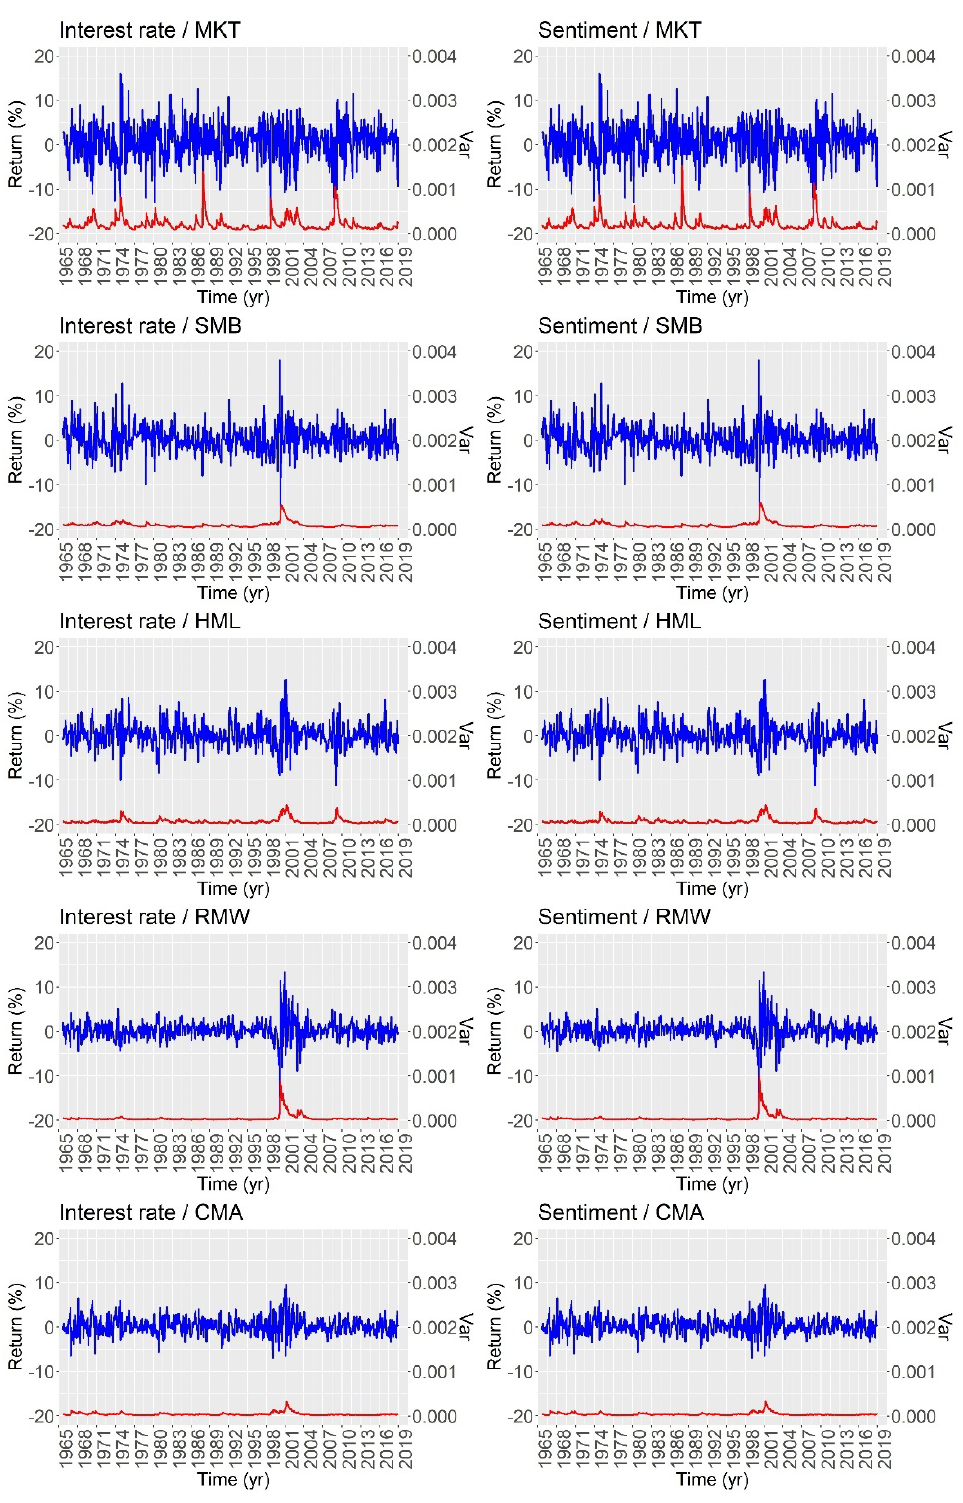
Figure 1. Five-factor returns and conditional variances of the GJR-GARCH(1,1)-M model. The left-hand side shows the effect of interest rates on five-factor asymmetric GARCH model, the right-hand side shows the effect of sentiments on five-factor asymmetric GARCH model. Blue lines and red lines indicate the factor return and conditional covariance, respectively. MKT, SMB, HML, RMW, and CMA denote the monthly return of the market, size, value, profitability, and investment factors, respectively. The sample period spans from July 1965 to December 2018.